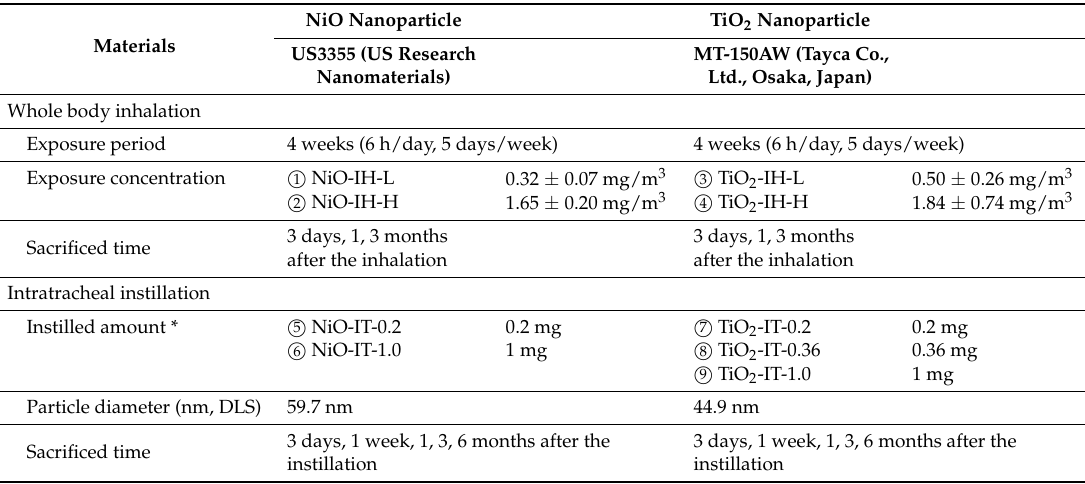
Table 2. Experimental